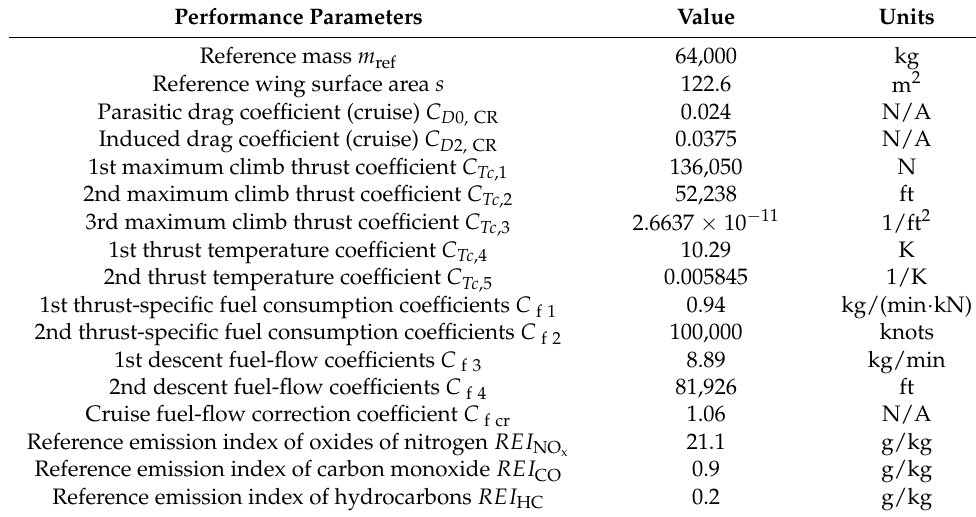
Table A2. Performance operational data of aircraft